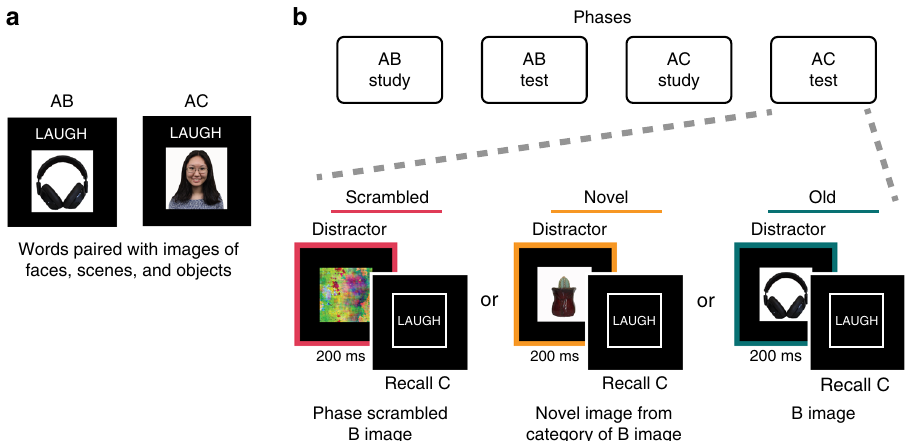
Fig. 1 Experimental design. a Across all experiments, subjects studied sets of overlapping word-image pairs (AB, AC pairs). Overlap was created by pairing two images (B and C terms) with the same word (A term). b Across all experiments, all AB pairs were studied (AB Study phase) and tested (AB Test phase) before AC pairs were studied/tested (AC Study phase/AC Test phase). The AC Test phase contained a critical manipulation in which each test trial was preceded by a brie fl y presented distractor image (200 ms). For Experiments 1 – 4, the distractor image was either a phase-scrambled version of the B image (Scrambled condition), a novel image from the same visual category as the B image (Novel condition), or the original B image (Old condition). For the behavioral pilot of the fMRI experiment and for the fMRI experiment, the Scrambled condition was